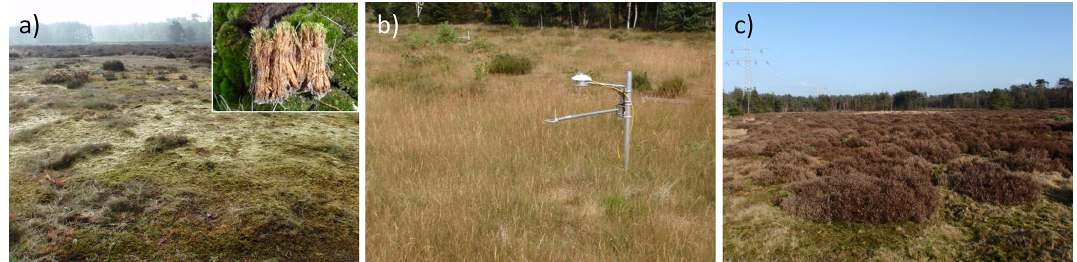
Figure 2. The vegetation types studied in this paper, (a) the moss surface with an approximately 2cm thick layer of Campylopus introflexus (inset), (b) the grass surface, primarily Agrostis vinealis and (c) the heather surface, Calluna vulgaris .